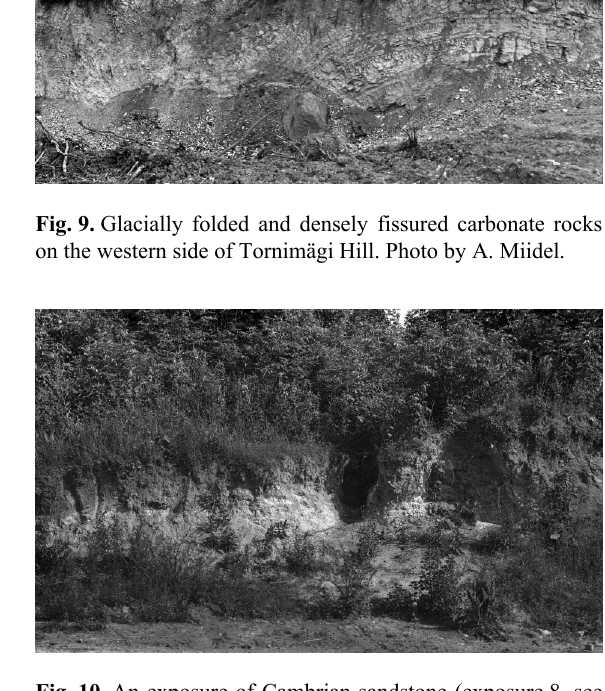
Fig. 10. An exposure of Cambrian sandstone (exposure 8, see Fig. 5) on the southern side of Pargim(cid:228)gi Hill. Photo by A. Miidel.